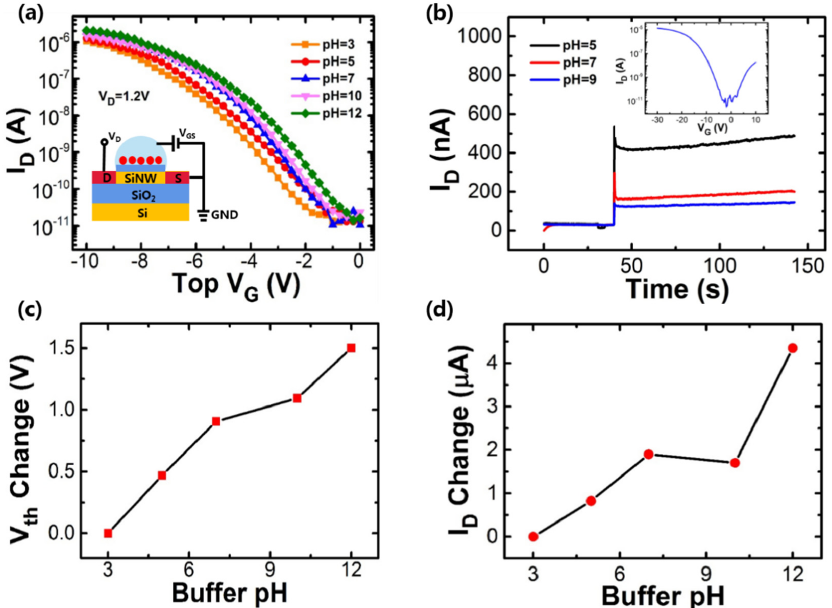
Figure 8. ( a ) The transfer curves of the poly-Si NW sensor by analyzing different pH solutions, ( b ) real-time response of I D when adding different pH solutions, the inserted figure the transfer curves of the bias back gate voltage, ( c , d ) threshold voltage and drain current change under different pH solutions.